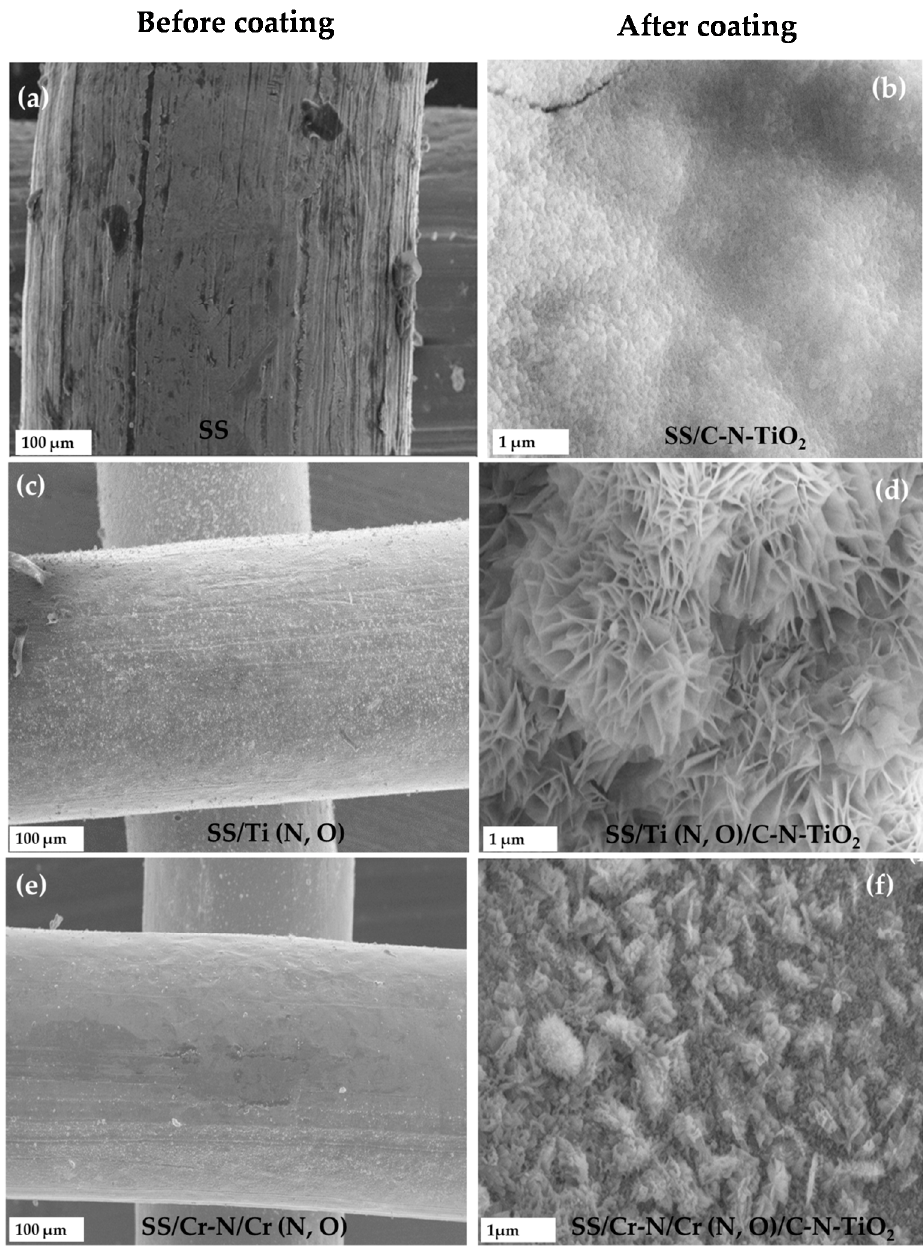
Figure 2. Scanning electron microscopy (SEM) of uncoated ( a , c , e ) and C-N-TiO 2 coated ( b , d , f ) stainless steel and anticorrosion meshes.